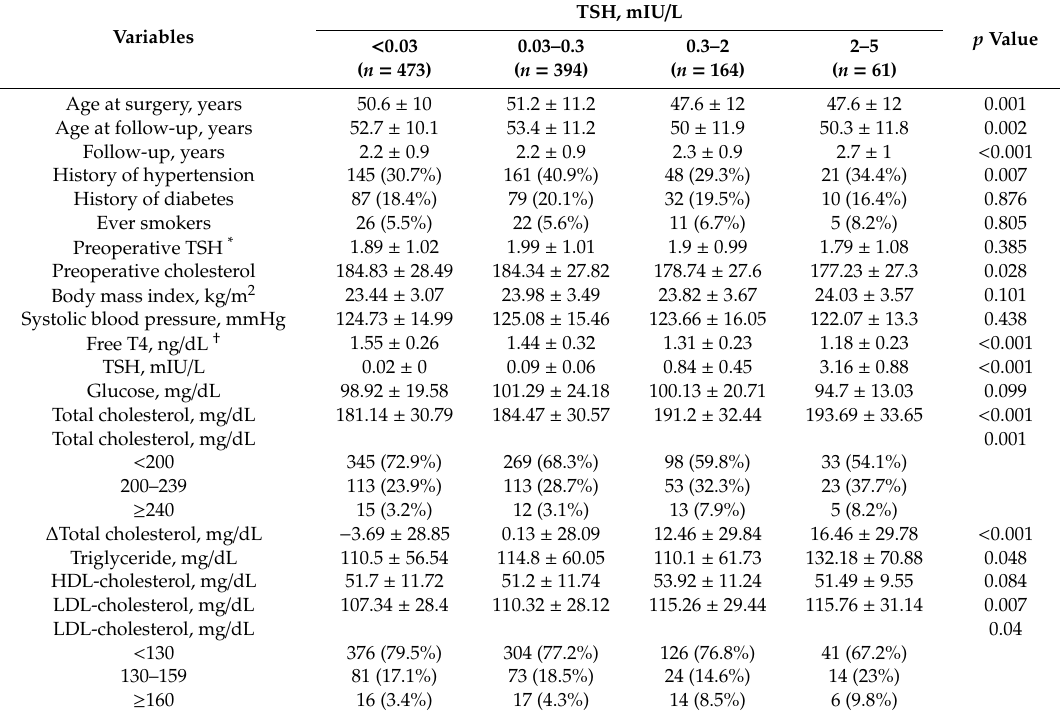
Table 1. Descriptive statistics by TSH